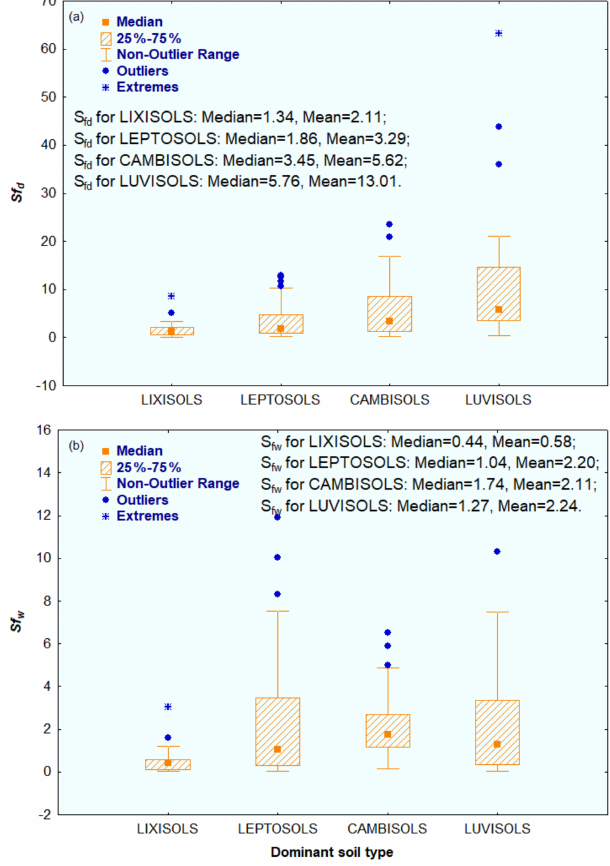
Figure 3. Comparisons of ecohydrological sensitivity grouped by energy-limited (EL), equitant (EQ) and water-limited (WL) condi- tions in the (a) dry season and (b) wet season ( S f d and S f w are dry season ecohydrological sensitivity and wet season ecohydrological sensitivity, respectively).